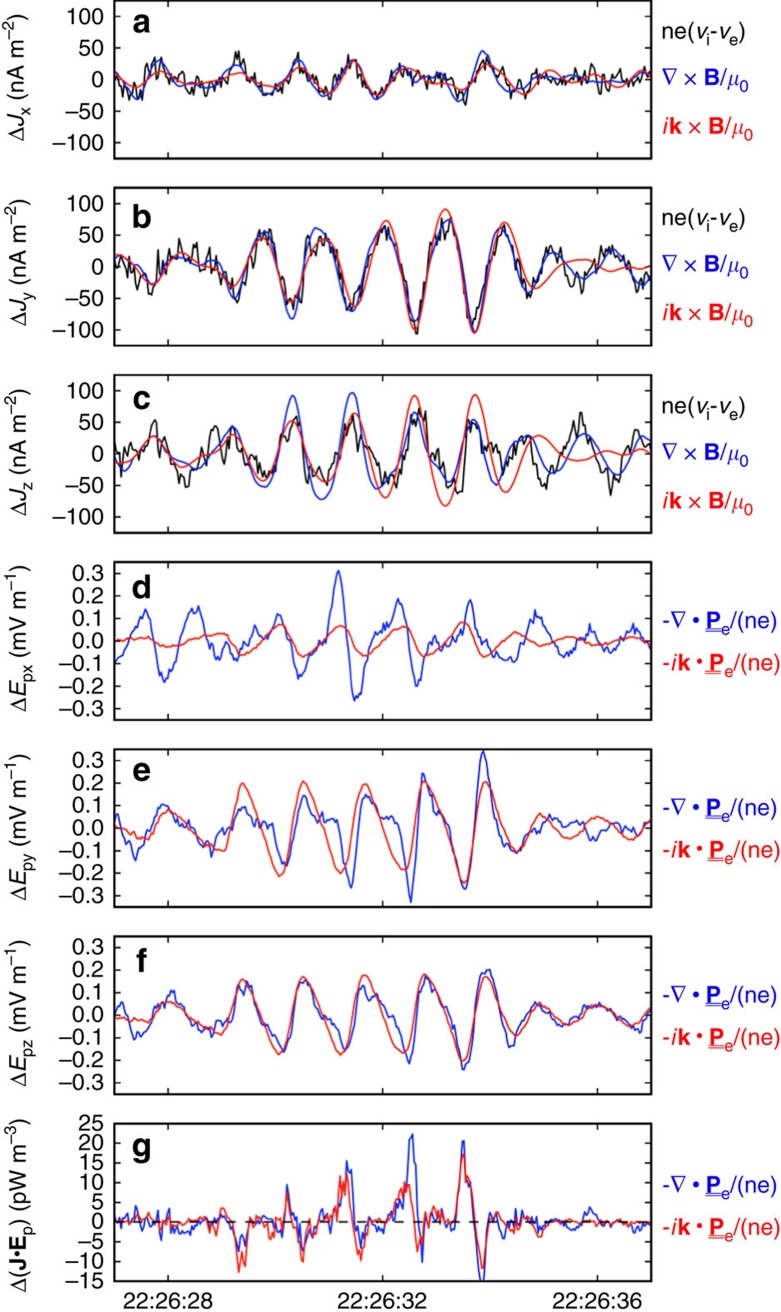
Comparison of current and electric field estimates.(a–c) MMS-averaged current fluctuations (ΔJ) derived from the curlometer technique (blue), four-spacecraft-averaged particle observations (black) and four-spacecraft-averaged plane-wave approximation using k=[7.1 × 10−3, −2.0 × 10−2, −2.2 × 10−2] km−1 (red). (d–g) MMS-averaged ΔEp and Δ(J·Ep) derived from the divergence of the electron pressure tensor (blue) and from the plane-wave approximation (red). Agreement between all quantities provides additional confidence in the estimation of k.